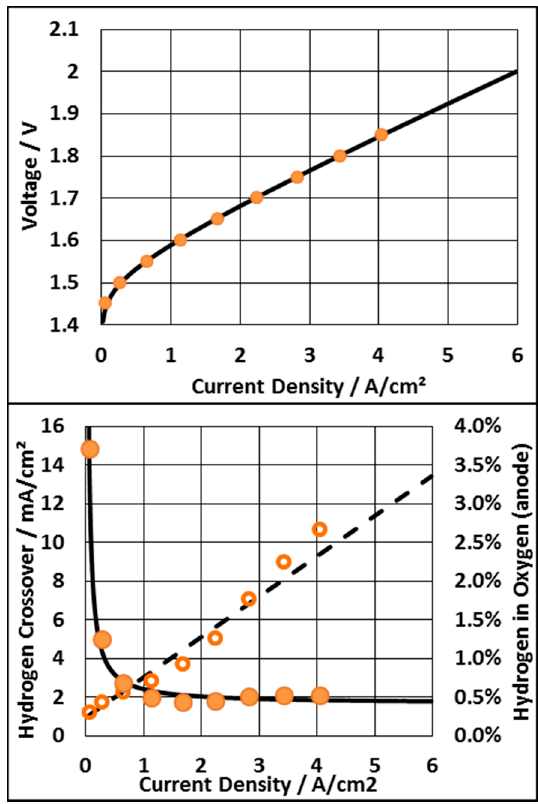
Figure 3. Top : Cell voltage as a function of current density of the real data (orange dots) and the fit (black). Bottom : Hydrogen concentration in oxygen (line) and hydrogen crossover current density (dashed) as a function of current density. The real data are shown as orange